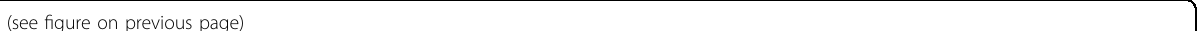
Fig. 4 Assessment of changes in T cells in transcriptional pro fi les between MG patients and healthy controls. a UMAP plot displaying T cells and NK cells from two MG patients and two HCs separated into 21 subtypes. b Violin plots showing key gene markers across T cells and NK cells. c Enrichment analysis of DEGs in CD4 + T cells between MG patients and HCs (selected among upregulated pathways in MG patients, P value < 0.05). d CD4 + T cells were sorted using the DDRTree algorithm and projected onto the different cell states using the color in a . e UMAP plots showing expression of the STAT3 , JUND , and JUN genes in CD4 + T cells (top) and the AUC of the estimated regulon activity of the corresponding TFs, predicting the degree of expression regulation of their target genes (bottom). f Heatmap of the AUC scores of expression regulation by transcription factors (regulon activity) as estimated using SCENIC, followed by comparisons between two groups using t -test. The top 20 transcription factors with the highest upregulated expression in MG are